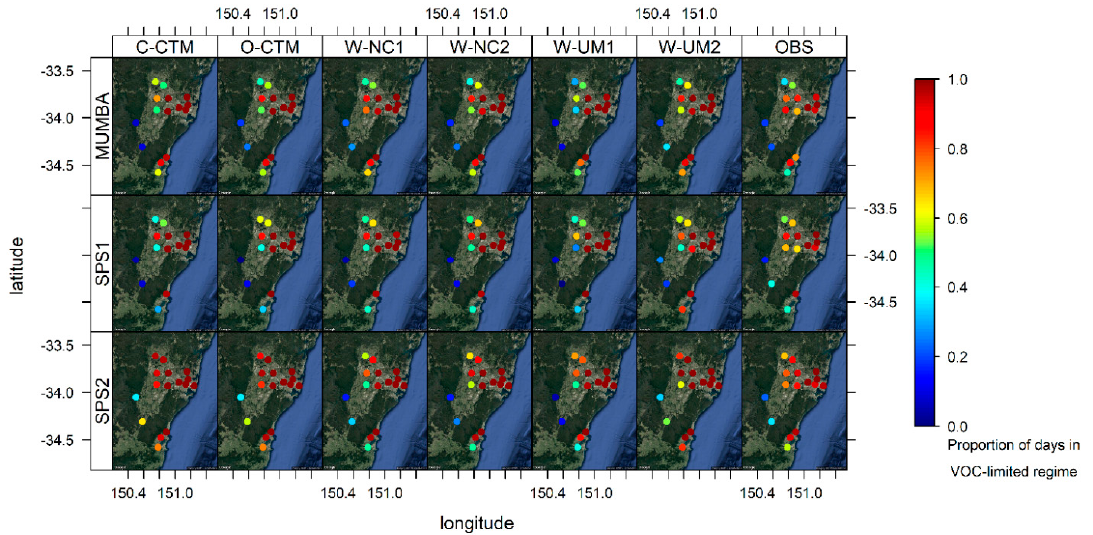
Figure 7. Maps showing proportion of days in VOC-limited O 3 production regime observed (right-most column) and in each of the models for each campaign.